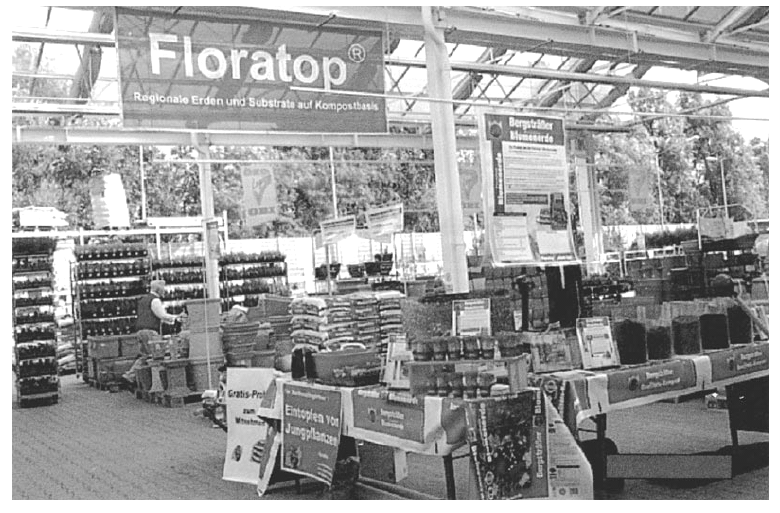
Figure 14: This compost (FLORATOP -Brand) presentation in a super- market can really compete with bark and peat pro-